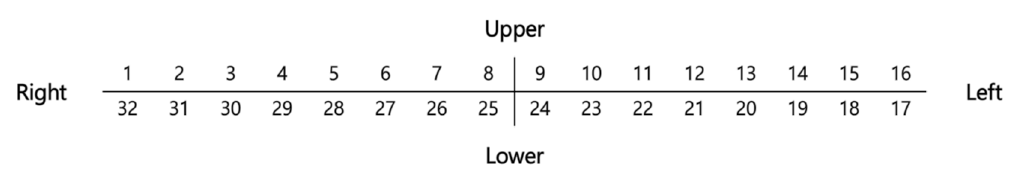
Figure 1. Universal numbering system (human teeth).